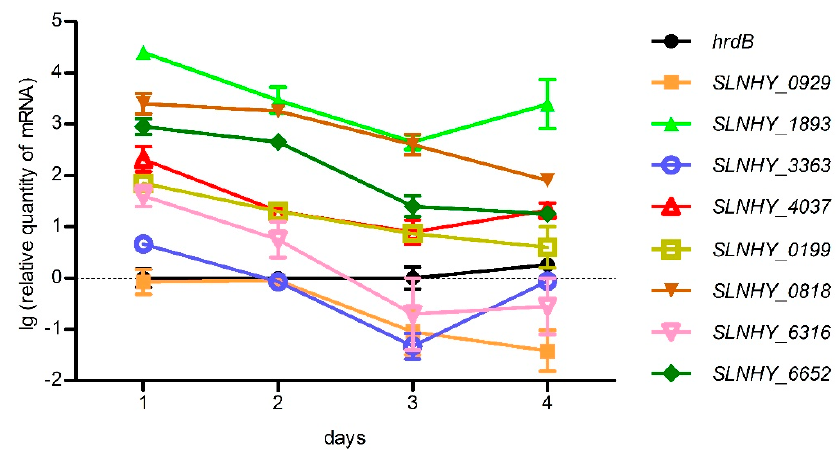
Figure 4. Transcription profiles of eight exporter genes. Line with black circle, hrdB ; orange square, SLNHY_0929 ; green equilateral solid triangle, SLNHY_1893 ; blue circle, SLNHY_3363 ; red equilateral hollow triangle, SLNHY_4037 ; earthy yellow hollow square, SLNHY_0199 ; brown inverted solid triangle, SLNHY_0818 ; pink inverted hollow triangle, SLNHY_6316 ; dark green rhombus, SLNHY_6652 . Logarithm of transcription data were taken as ordinate; if not, it would be difficult to show their wide fluctuation scales.